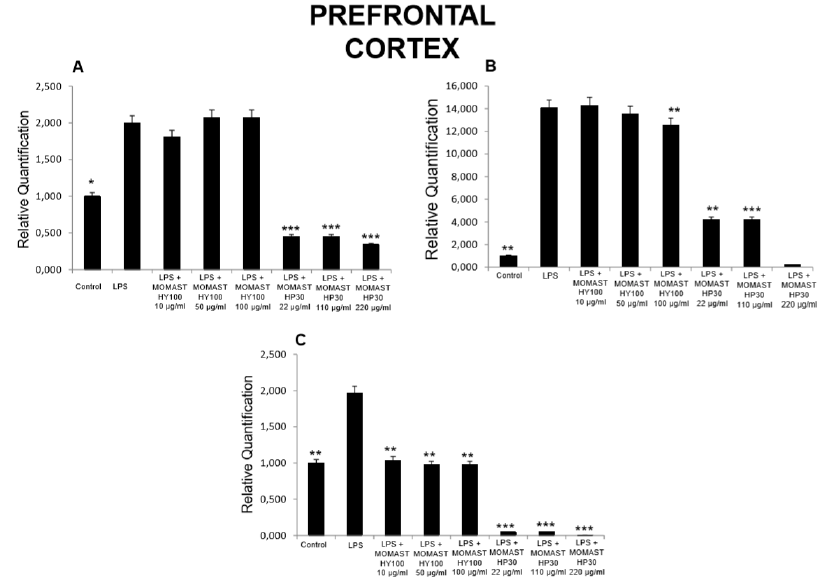
Figure 5. Effects of MOMAST( ® ) HY100 (10, 50, and 100 µg/mL) and MOMAST( ® ) HP30 (22, 110, and 220 µg/mL) on ( A ) cyclooxygenase (COX)-2, ( B ) tumor necrosis factor α (TNF α ), and ( C ) inducible nitric oxide synthase (iNOS) in rat prefrontal cortex specimens. Data were reported as means ± SEM. ANOVA, p < 0.01; post-hoc test, * p < 0.05, ** p < 0.01, *** p < 0.001 vs. LPS-treated group.